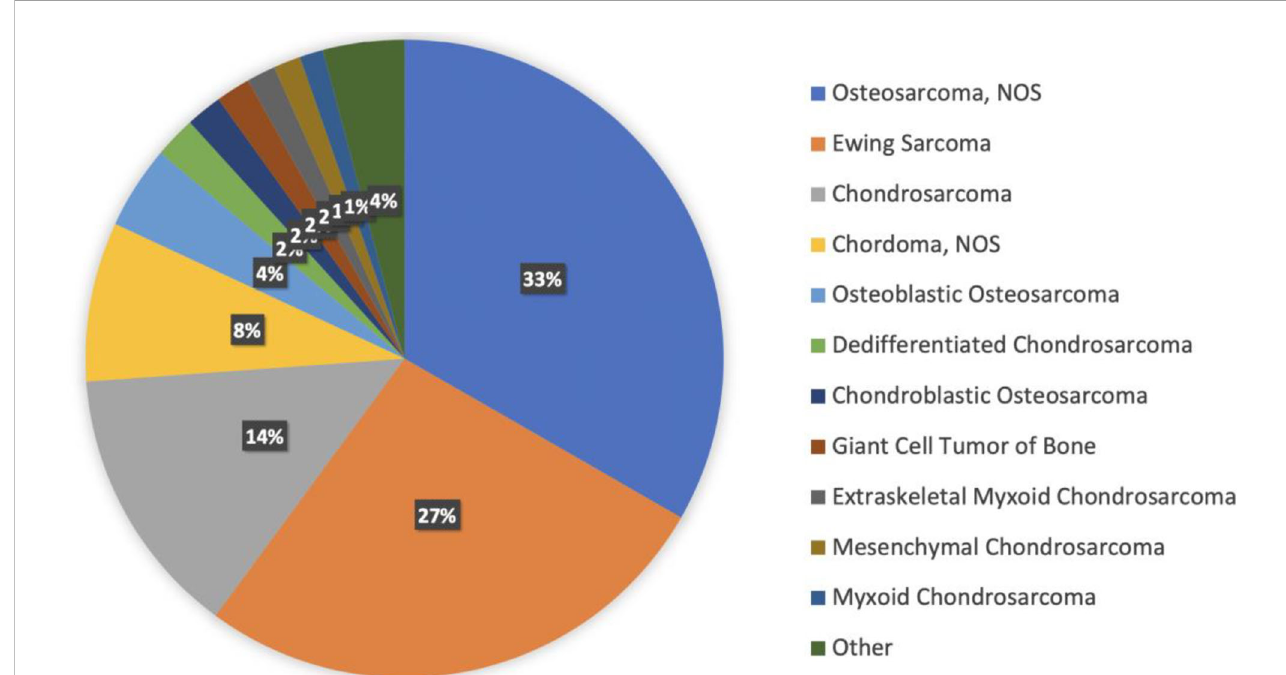
FIGURE 2 Histology distribution within the bone sarcoma cohort, including all histologies representing at least 1% of